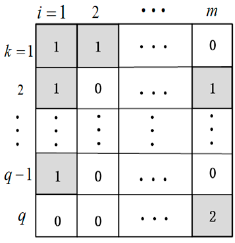
Figure 5. 2D binary coding for a channel allocation scheme.